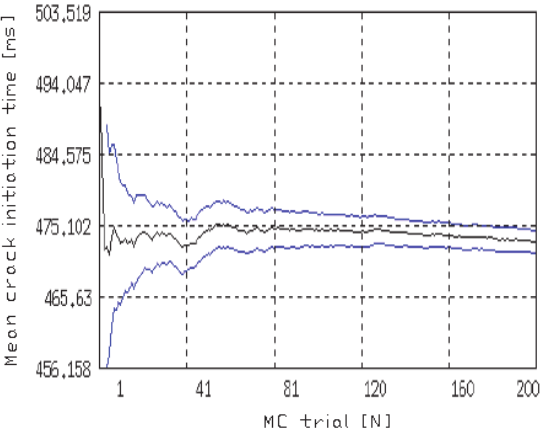
Figure 7: Mean of the crack init. time [ms] vs. MC trial.